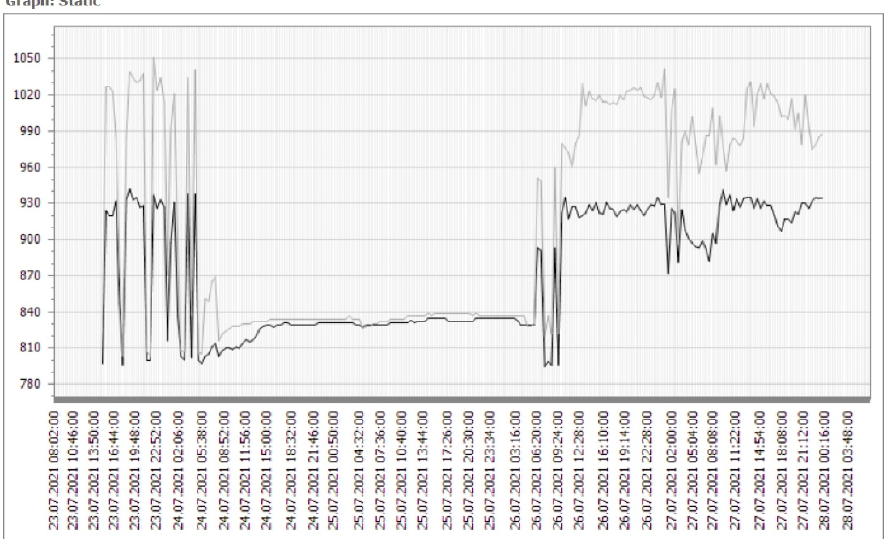
Figure 19. Original telemetry records for wells Z-4 and Z-5 (upper picture—water temperature, lower picture—electrical conductivity (µS/cm).